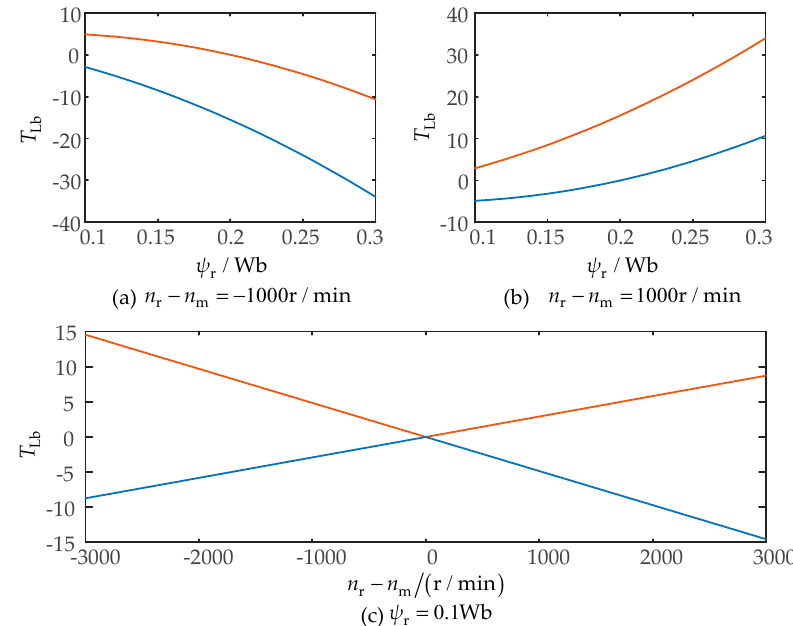
Figure 6. Influence of rotor flux and the speed difference on the load torque boundary. ( a ) Influence of rotor flux when n r − n m < 0. ( b ) Influence of rotor flux when n r − n m > 0. ( c ) Influence of the speed difference.